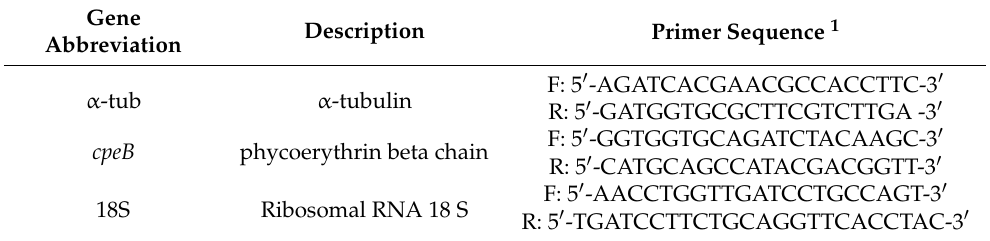
Table 1. List of primers used.